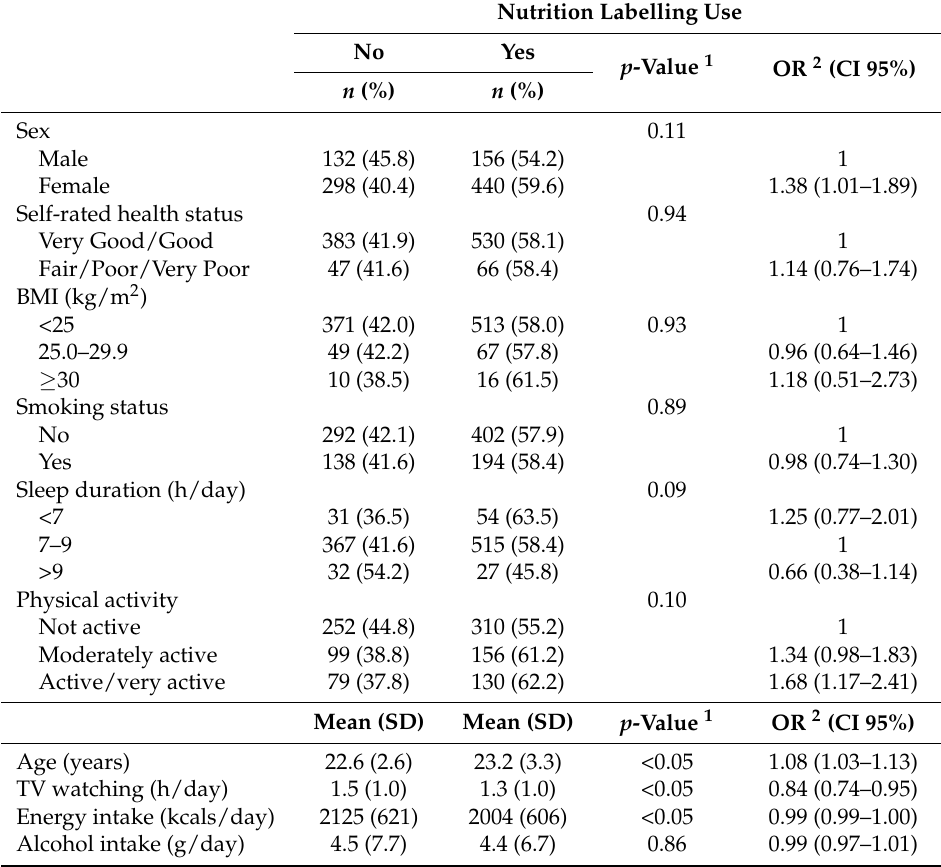
Table 1. Socio-demographic and lifestyle characteristics according to the nutrition labelling use and its predictor factors in participants aged 17–35 years from the DiSA-UMH (Dieta, Salud y